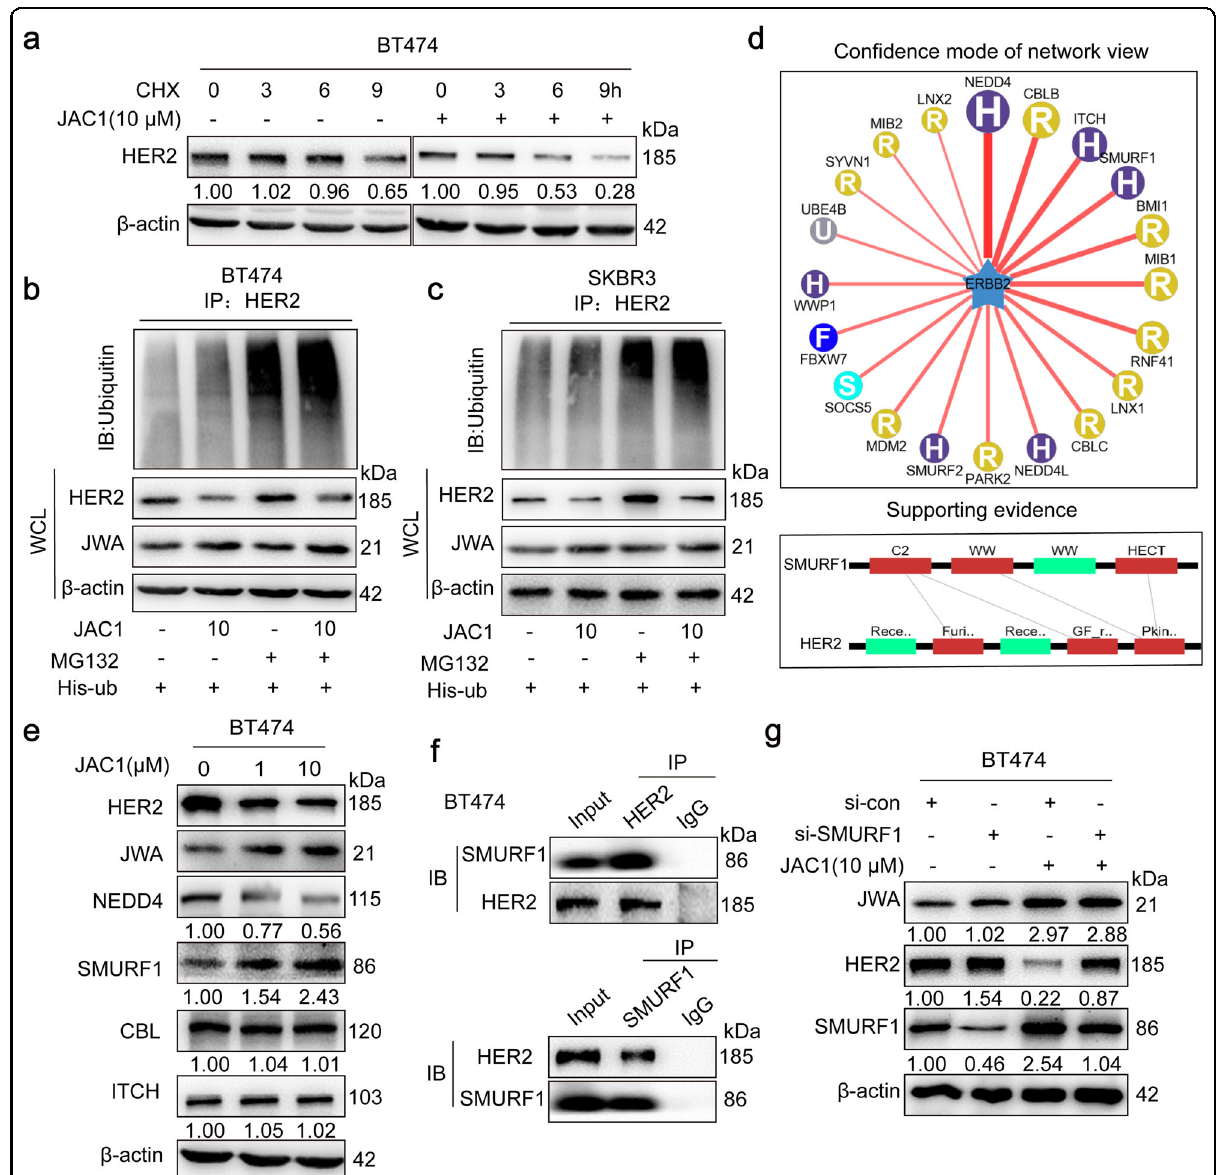
Fig. 3 JAC1 downregulates HER2 expression via ubiquitin – proteasome pathway. a BT474 cells were treated with the JAC1 (0, 1, 10 μ M) for 24 h, followed by Cycloheximide (CHX, 100 μ g/mL) for 0, 3, 6, 9 h. HER2 protein expressions were determined by western blot. b , c Ubiquitination of HER2 was induced by JAC1. Ubiquitination of the HER2 protein was immunoprecipitated and detected a ubiquitin antibody. d The HER2-targeting E3 ubiquitin ligases were predicted using the public database website (ubibrowser.ncpsb.org/). e After BT474 cells were treated with the JAC1 (0, 1, 10 μ M) for 24 h, the expressions of E3 ligases which were ranked at the top were determined by western blot. f BT474 cells were pretreated with MG132 (10 μ M) for 6 h, and the endogenous protein – protein interaction between SMURF1 and HER2 was assessed by IP and followed by western blot. g Western blotting analysis of HER2 and SMURF1 in BT474 cells treated with JAC1 or si-SMURF1 and corresponding